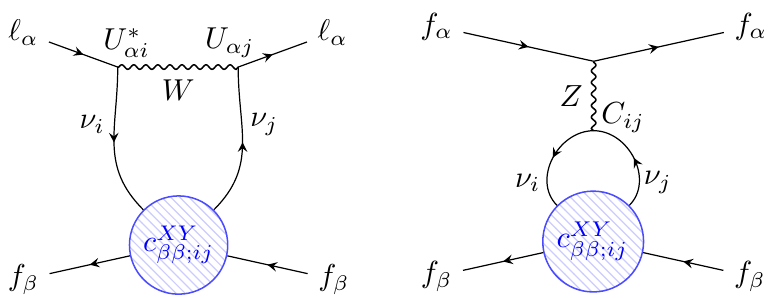
Figure 3 . Diagrams depicting the exchange of two massive neutrinos between fermions f (cid:11) and f (cid:12) with SM CC and NC interactions at one vertex and an e(cid:11)ective four-fermion interaction at the other. In our framework the e(cid:11)ective interaction may be of vector ( c XY ( h XY ) (cid:11)(cid:12) ; ij